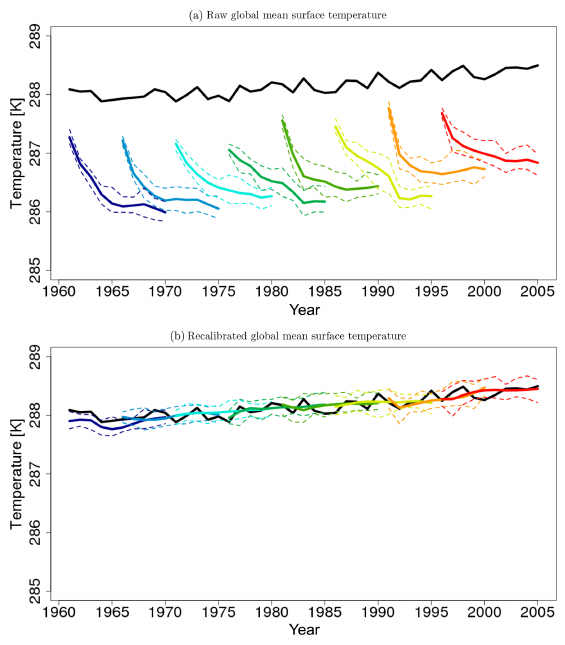
Figure 7. Temporal evolution of global yearly mean surface temper- ature from MiKlip prototype (a) before and (b) after recalibration with DeFoReSt. Shown are different start years with 5-year intervals (colored lines). The black line represents the surface temperature of NCEP 20CR. Units are in Kelvin